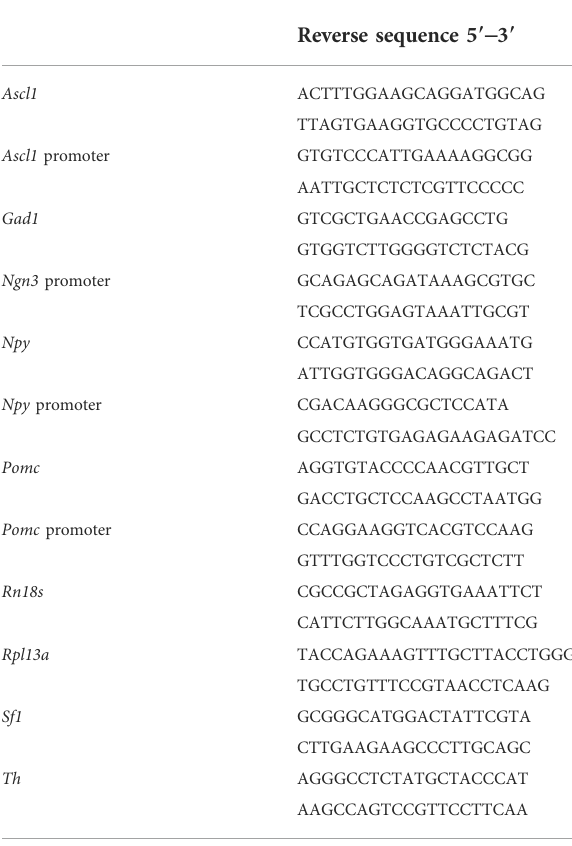
TABLE 1 Primer sequences used for qPCR